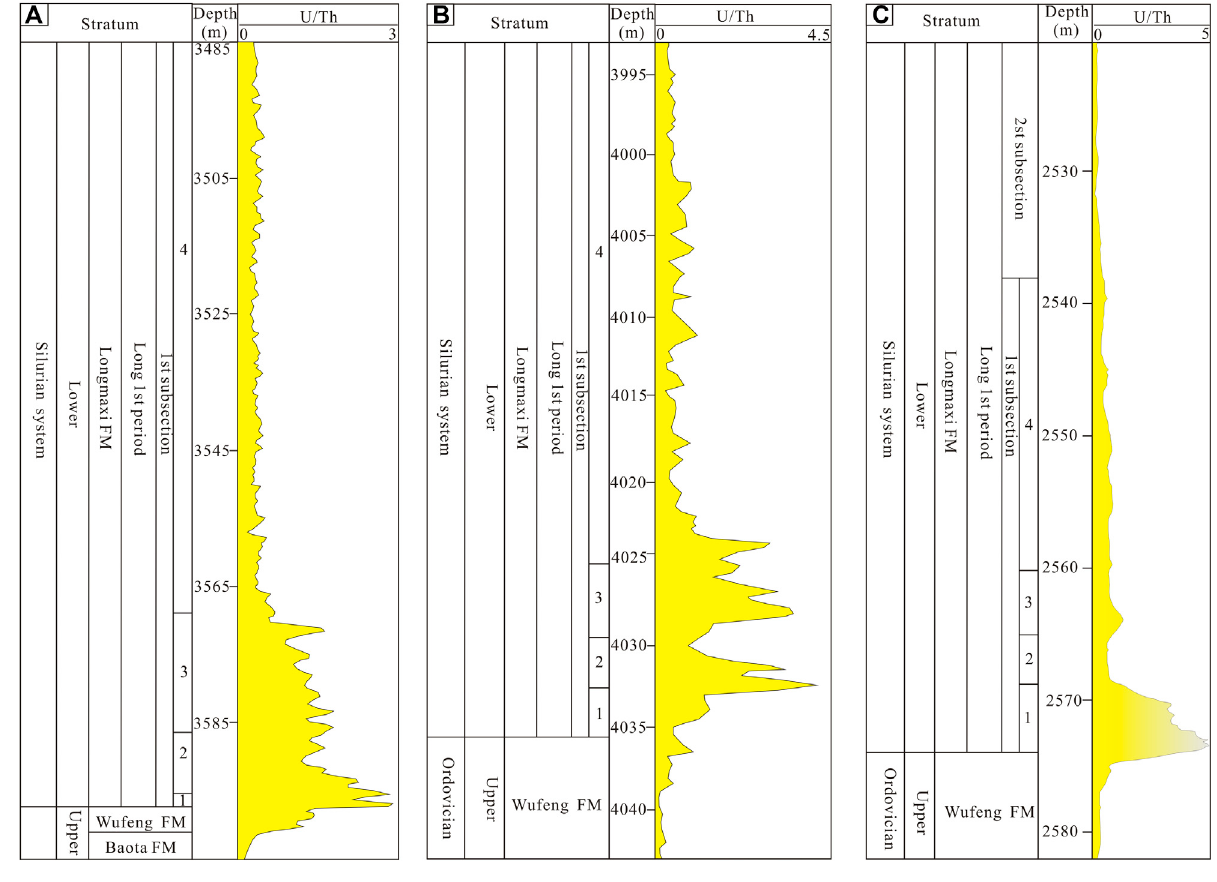
Frontiers in Earth Science |